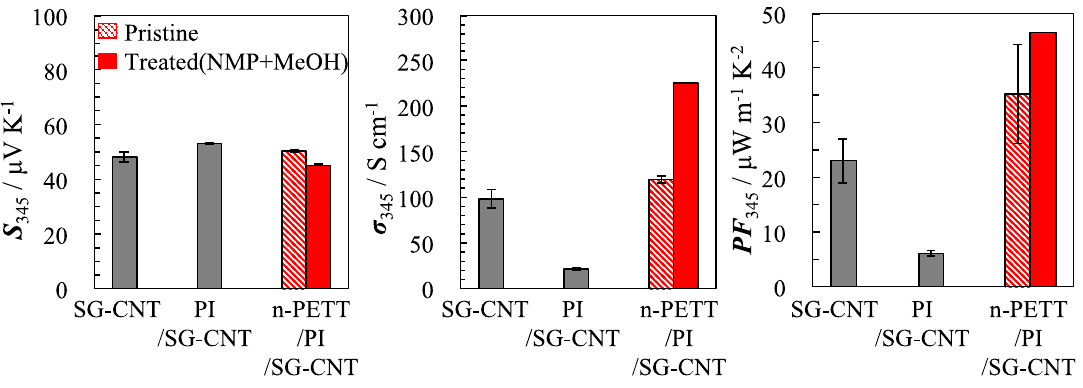
Figure 2. Seebeck coefficient ( S ), electrical conductivity ( σ ) and power factor ( PF ) of SG-CNT sheet, PI/SG-CNT and nano-PETT/PI/SG-CNT. Mass ratios are PI/SG-CNT = 12/8, and nano-PETT/PI/SG-CNT = 9/3/8. All films have a thickness of 10 µm.